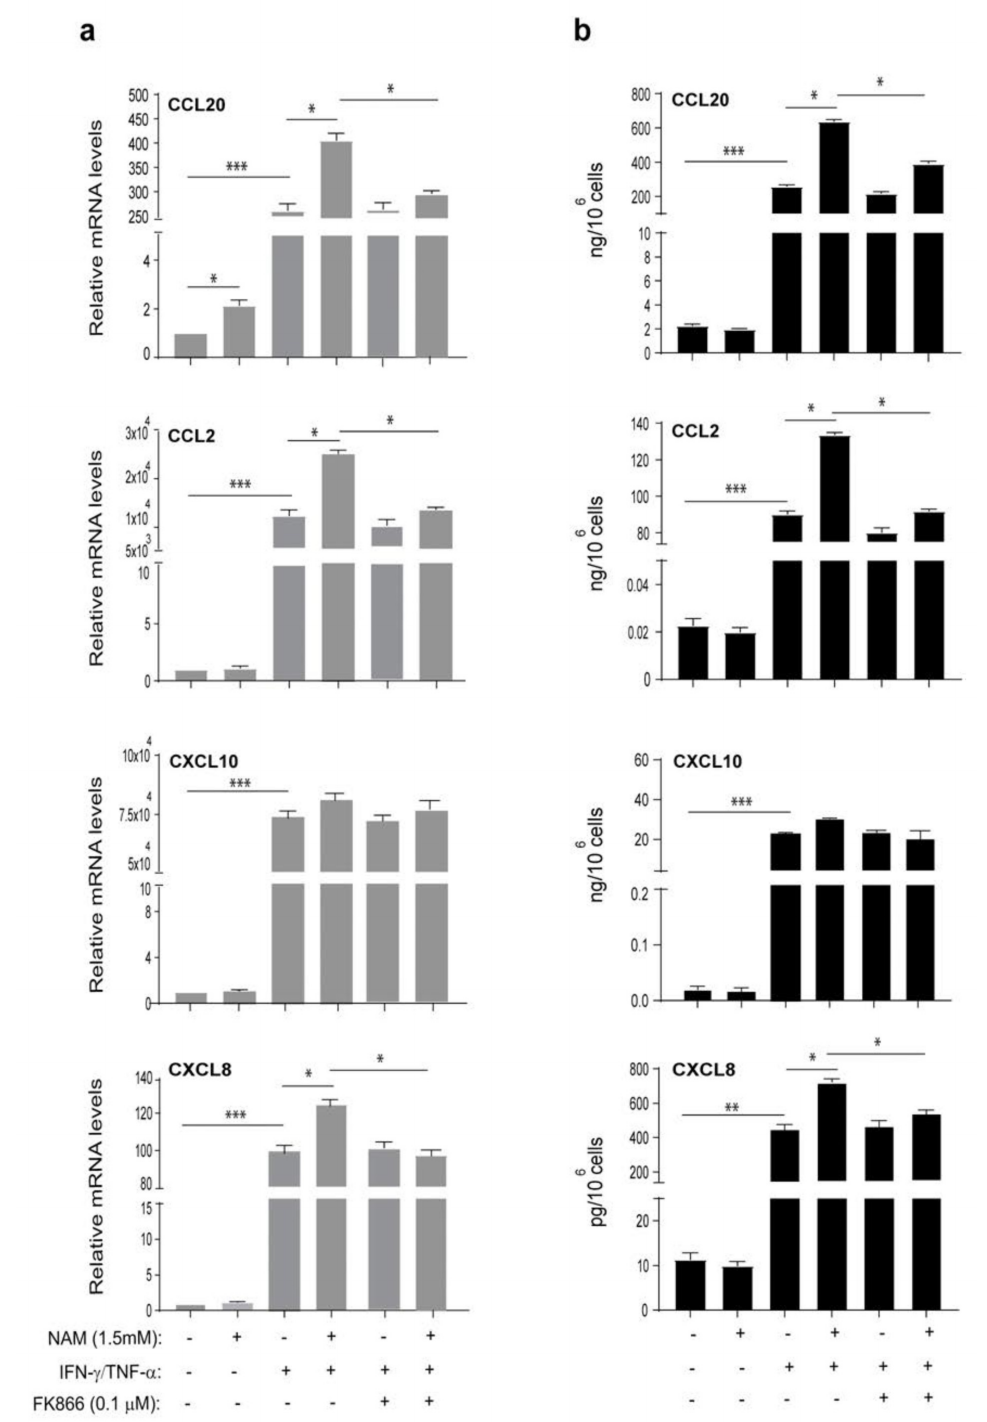
Figure 4. Intracellular NAD + boosting by NAM supplementation enhances IFN- γ /TNF- α -induced expression and release of CCL20, CCL2 and CXCL8 by human keratinocytes. ( a , b ) Keratinocyte and fibroblast cultures were left untreated or stimulated with a combination of IFN- γ (200 U/mL)/TNF- α (50 ng/mL) in presence or absence of NAM (1.5 mM) for 24 h. Keratinocytes and fibroblasts activated by cytokines in presence of NAM were concomitantly treated with FK866 (0.1 µ M). ( a ) CCL20, CCL2, CXCL10 and CXCL8 mRNA expression was detected by real-time PCR and normalized to HPRT1 levels. ( b ) Chemokine production was analyzed by ELISA in supernatants obtained by cell cultures treated as described above. All data shown are the mean of three different experiments ± SD. * p ≤ 0.05, ** p ≤ 0.01, and *** p ≤ 0.001 compared with the untreated cultures, as assessed by paired Student’s t